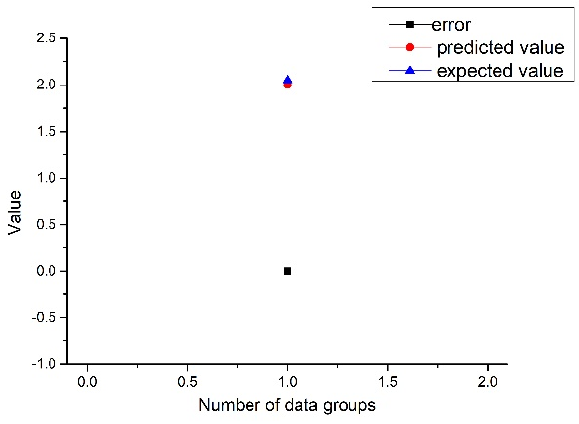
Figure 7. Data comparison